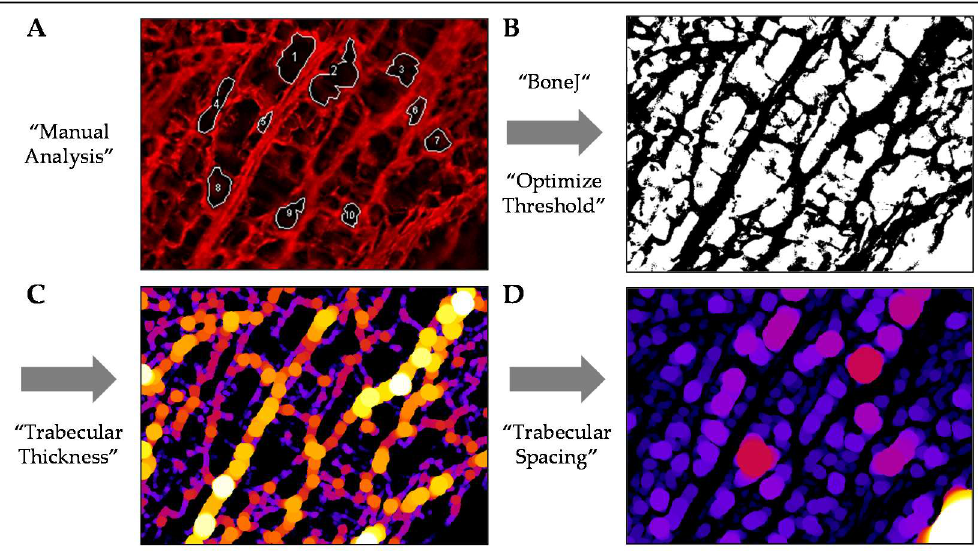
Figure 1. Analysis of the pore structure using the ImageJ software. ( A ) Fluorescent image of a sulforhodamine B (SRB) stained platelet-rich plasma (PRP) scaffold (100X magnification). Manual marking of the pores using the “polygon selection” tool will provide pore area, mean diameter, and circularity. ( B ) 8-bit binary image after optimizing the threshold with the “BoneJ” plugin. This allows automated analysis of factors, such as ( C ) “trabecular thickness” and ( D ) “trabecular spacing”.